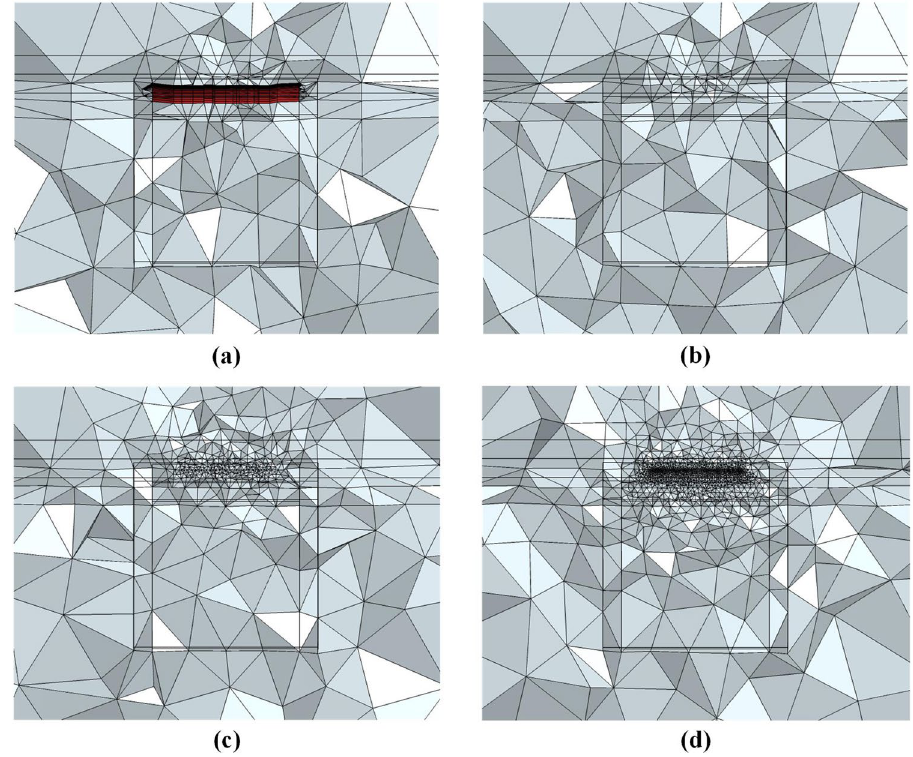
Figure 7. Grid diagram of the cross section of the three-dimensional layered geoelectric model. ( a ) is the cross section of Mesh A. The red part represents the triangular prism mesh, and the remaining part represents the tetrahedral mesh. ( b ) is the cross section of Mesh B1. ( c ) is the cross section of Mesh B2. ( d ) is the cross section of Mesh B3 40